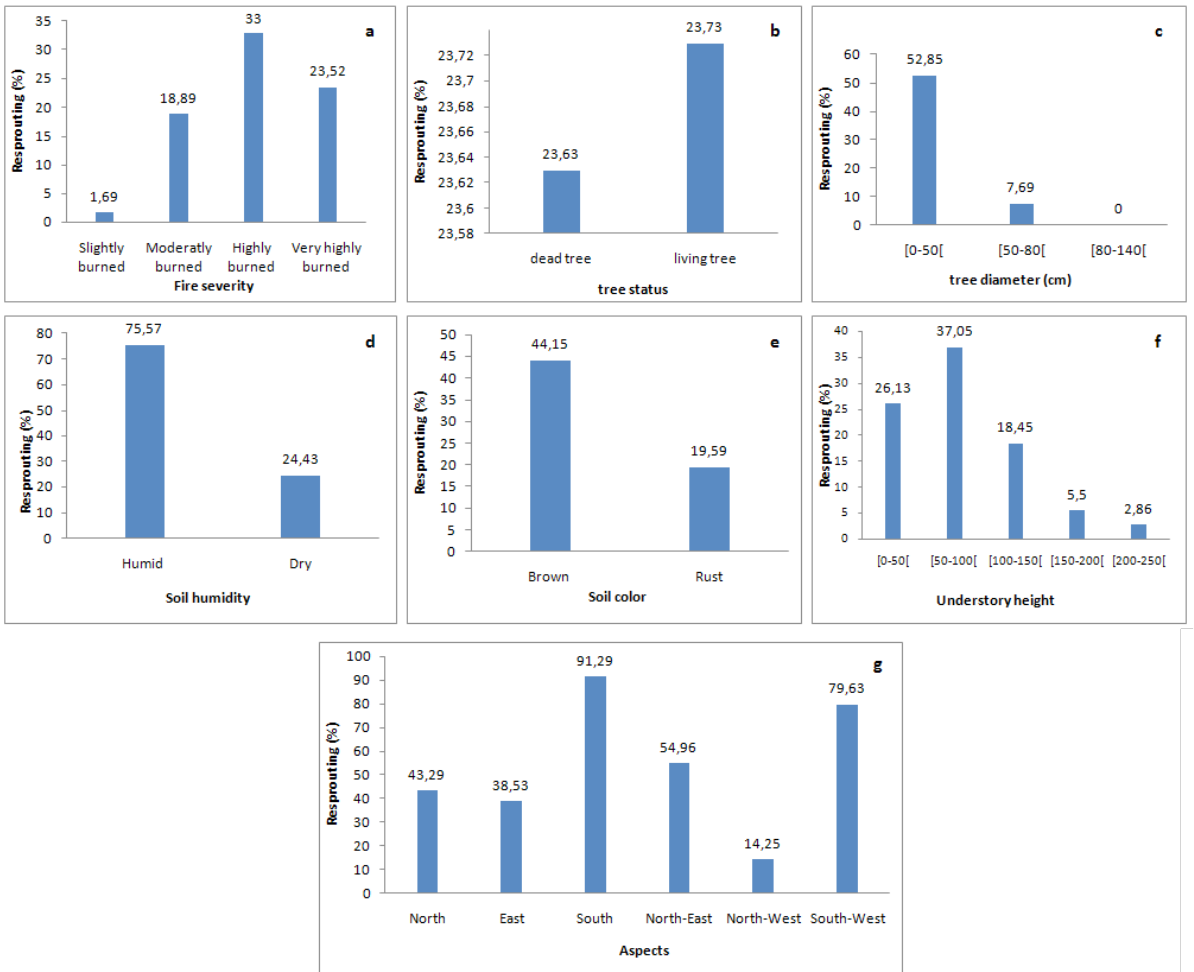
Figure 7. Percentages of trees presenting post-fire resprouting for each of the highly correlated